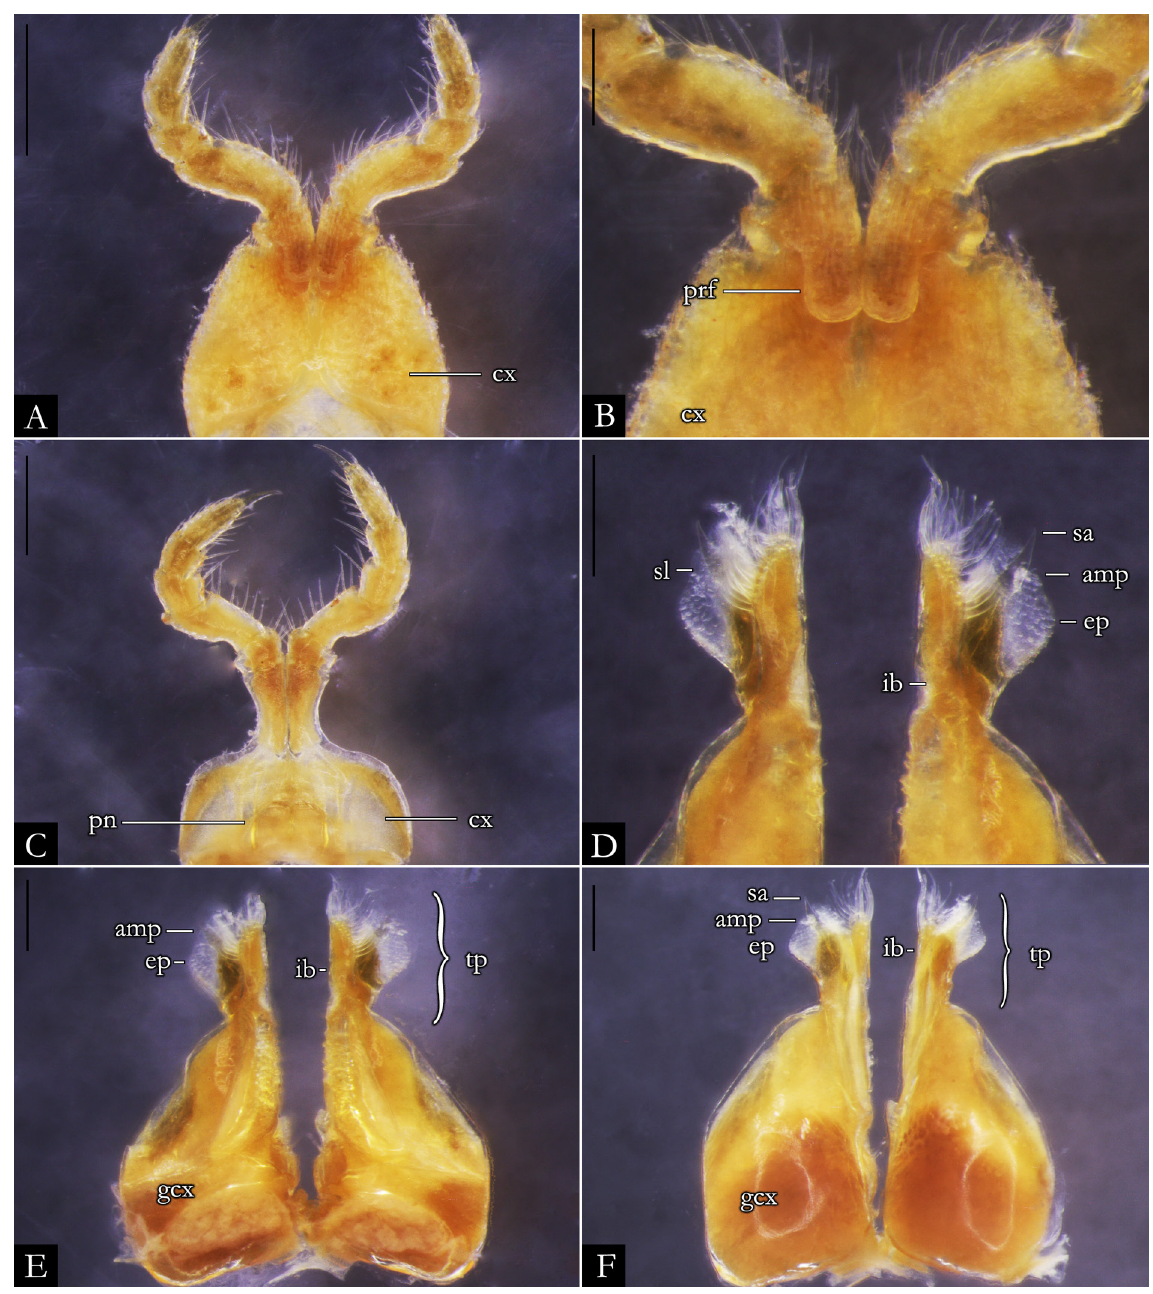
Fig. 102. Pseudonannolene ophiiulus Schubart, 1944, ♂ (MZSP 1061). A . First leg-pair. B . Detail of prefemur. C . Second leg-pair. D . Detail of telopodites, in anal view. E . Gonopods, in anal view. F . Gonopods, in oral view. Abbreviations: see Material and methods. Scale bars: A, C, E–F = 0.5 mm; B, D = 0.2